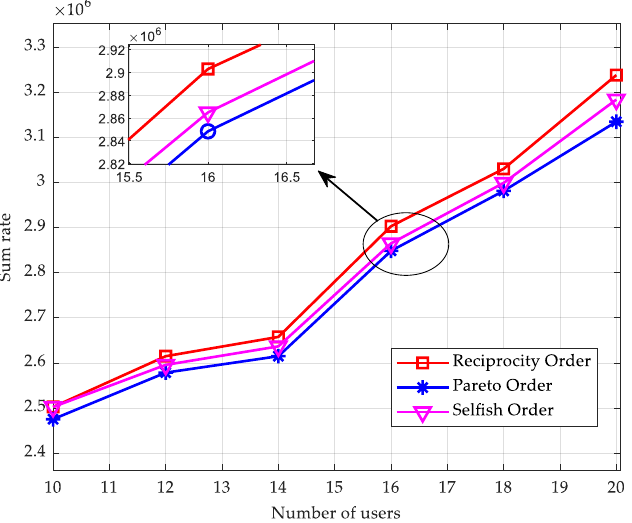
Figure 6. Schematic representation of the impact of the number of users on the performance of the proposed algorithm.